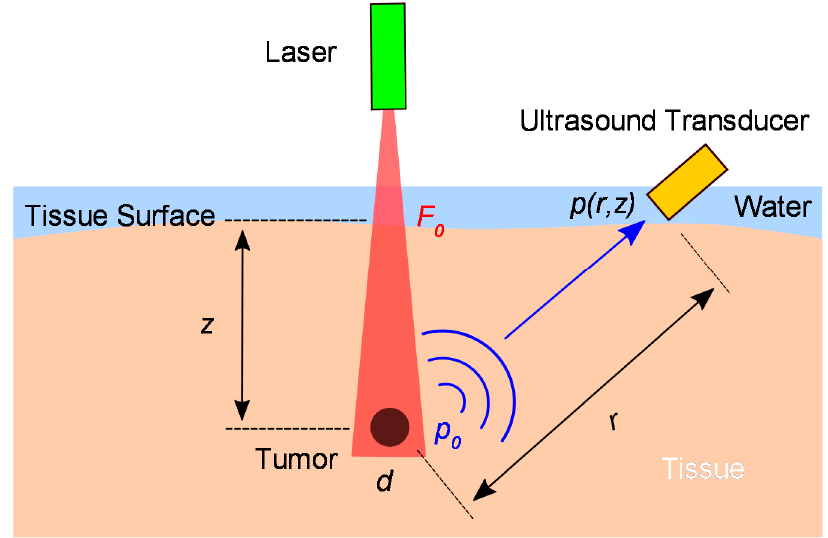
Figure 1. Diagram of laser illumination and photoacoustic wave detection in photoacoustic imaging (PAI).